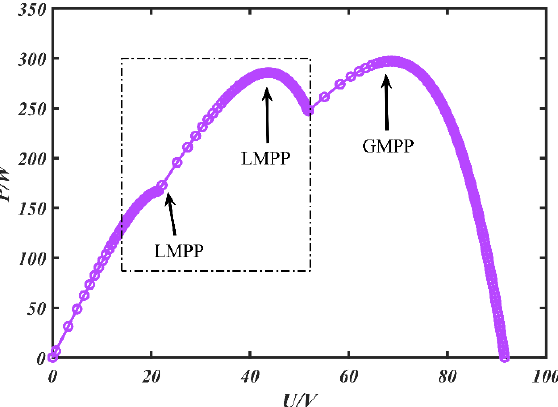
Figure 6. P ‐ U characteristic of photovoltaic array under PSC.